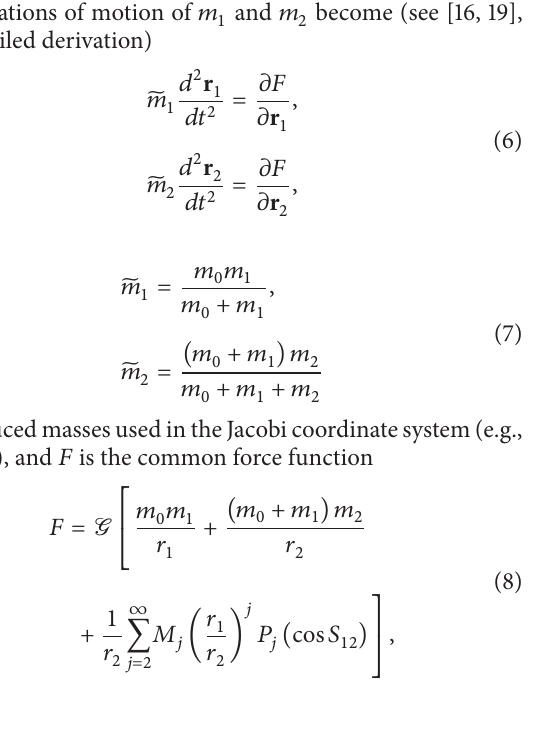
(𝑚 ) denoted as 𝐺 1